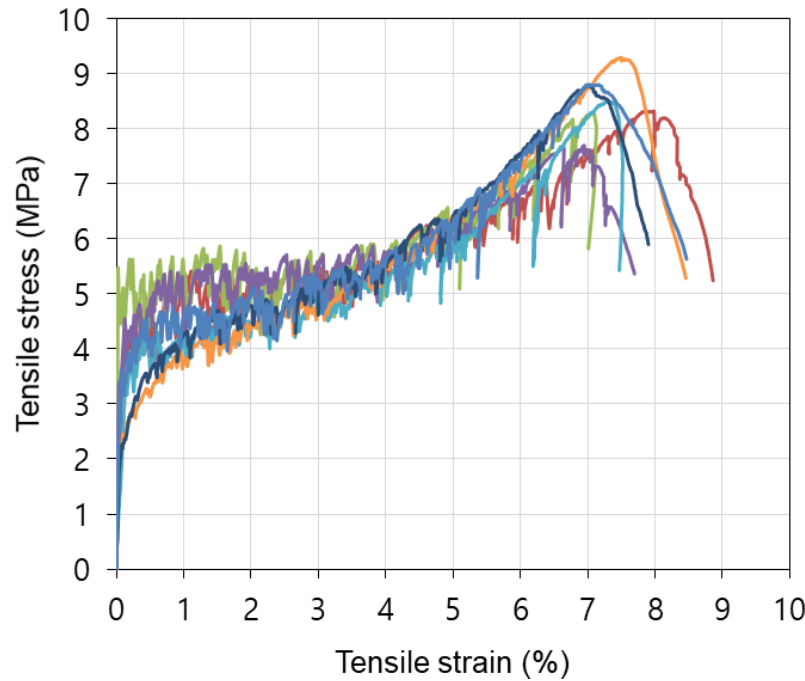
Figure 4. Tensile stress and tensile strain curves of specimens (different color of lines indicates different samples with identical mixture.).